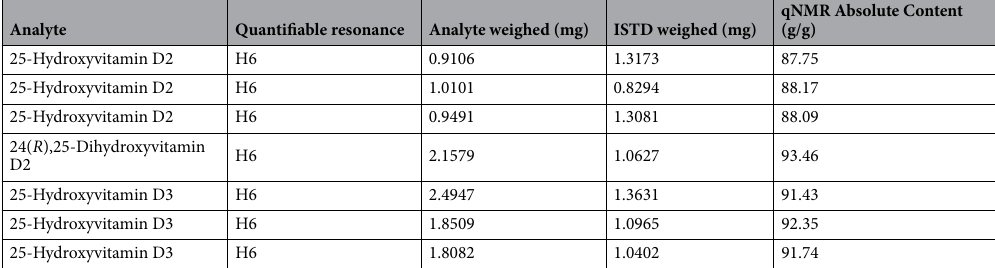
Table 1. Calculation of qNMR absolute content of analytes 1 , 2 and 4